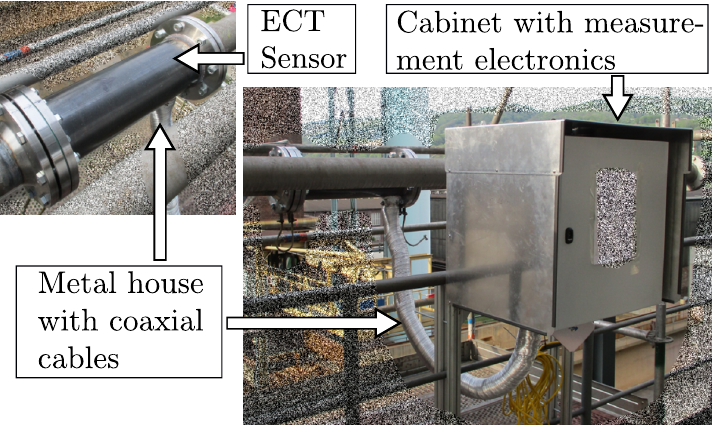
Figure 2. Photography of an ECT system in an industrial process plant. The measuring electronics is located in a cabinet, and the sensor electrodes and the electronics are connected via coaxial